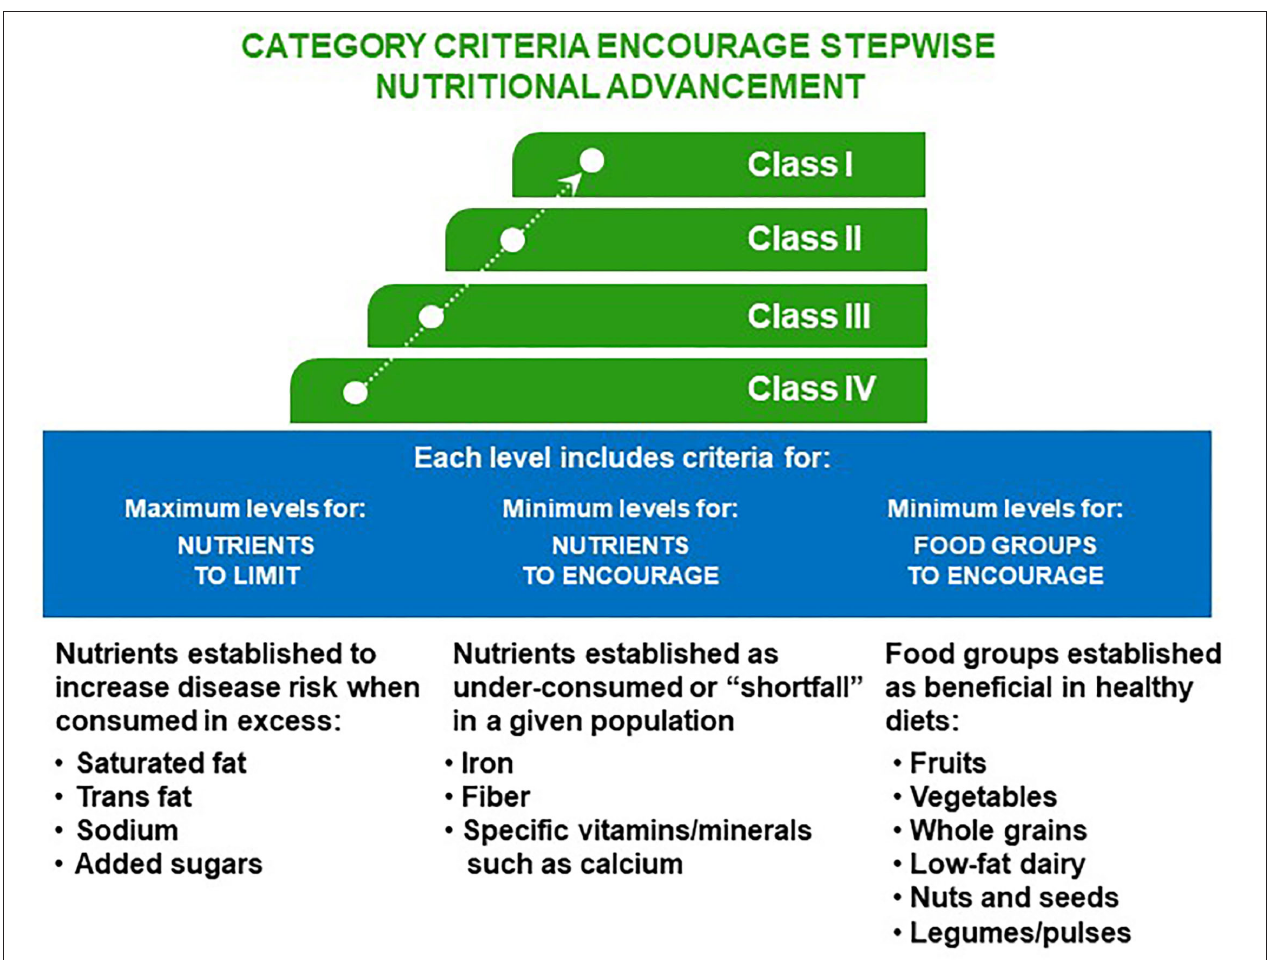
FIGURE 1 | Architecture of PepsiCo Nutrition Criteria (PNC). Nutrient density improves with stepwise progression from Class I to Class IV. Each level is precisely defined with goals of progressively limiting nutrients of concern and augmenting nutrients and food groups to encourage to guide and facilitate product formulation and reformulation in a practical